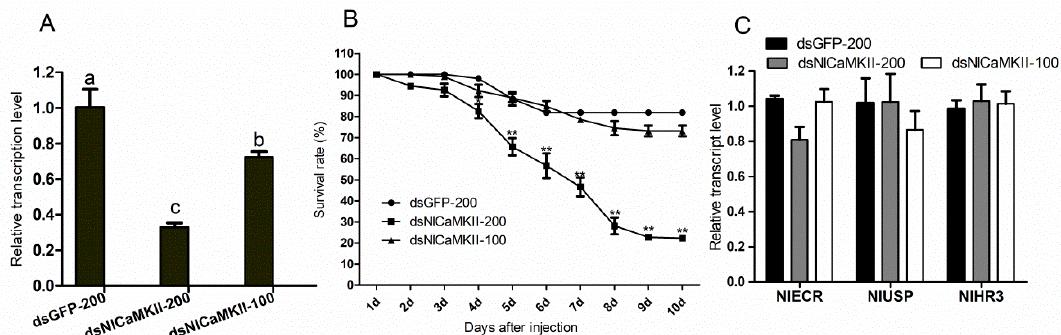
Figure 8. ( A ) The mRNA expression levels of NlCaMKII at the 4th day after injection with dsRNA. The di ff erent letters indicate significant di ff erences ( p < 0.05). Each point represents the mean ± SE from three independent experiments. ( B ) Survival rates of nymphs after injection with dsRNA. ** indicates significant di ff erences ( p < 0.01). Each point represents the mean ± SE from three independent experiments. ( C ) The mRNA expression levels of NlECR , NlUSP , and NlHR3 at the 4th day after injection with dsRNA. The mRNA levels for each cDNA were normalized with respect to the 18s-rRNA mRNA level. Fold induction values of CaMKII genes were calculated with the ∆∆ C t equation and normalized to the mRNA level of CaMKII genes in the control (injected with dsGFP-200) which were defined as 1.0. dsGFP-200: nymphs injected with 200 ng dsRNA of GFP ; dsNlCaMKII-200: nymphs injected with 200 ng dsRNA of NlCaMKII ; and dsNlCaMKII-100: nymphs injected with 100 ng dsRNA of NlCaMKII .